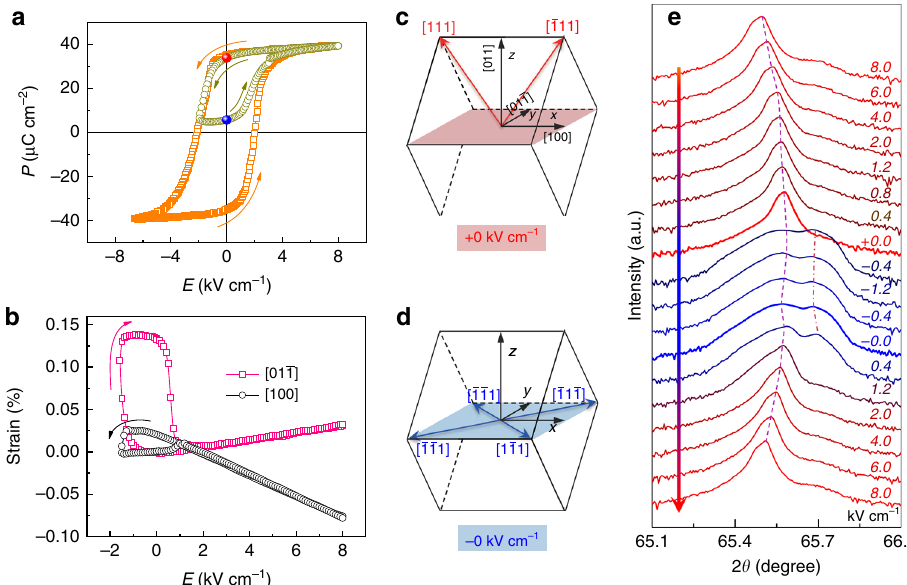
Fig. 3 Non-volatile strain property of PMN-PT (011). a P-E loops of PMN-PT with symmetric and asymmetric bipolar electric fi elds. b Non-volatile piezostrain ε ε fi eld curves along the [100] and [011] directions, respectively, with asymmetric bipolar electric fi elds. The arrows in a and b indicate x and y versus electric the electric- fi eld sweeping directions. c , d Illustration of the FE polarization structure of PMN-PT for E = ±0kVcm − 1 , respectively. The rhombohedral crystal structure of PMN-PT (011) has eight spontaneous ferroelectric polarization directions along the <111> directions (the body diagonals of the pseudocubic unit cell); that is, four possible polarization directions lie in the (011) plane, while two point upward and two downward, respectively. e Evolution of the PMN-PT (022) diffraction peaks with varying electric fi elds, in which the electric fi eld swept following the procedure indicated by the